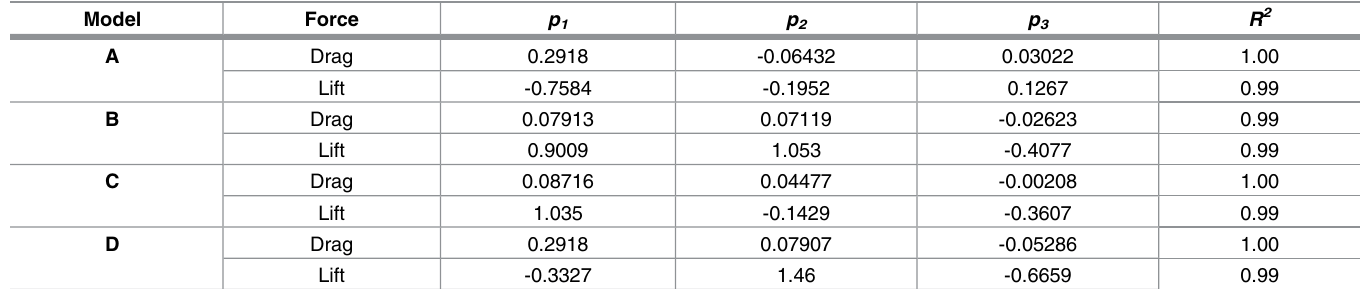
Table 3. Coefficients and R 2 values for the second order polynomial fits presented in Fig 7. Model